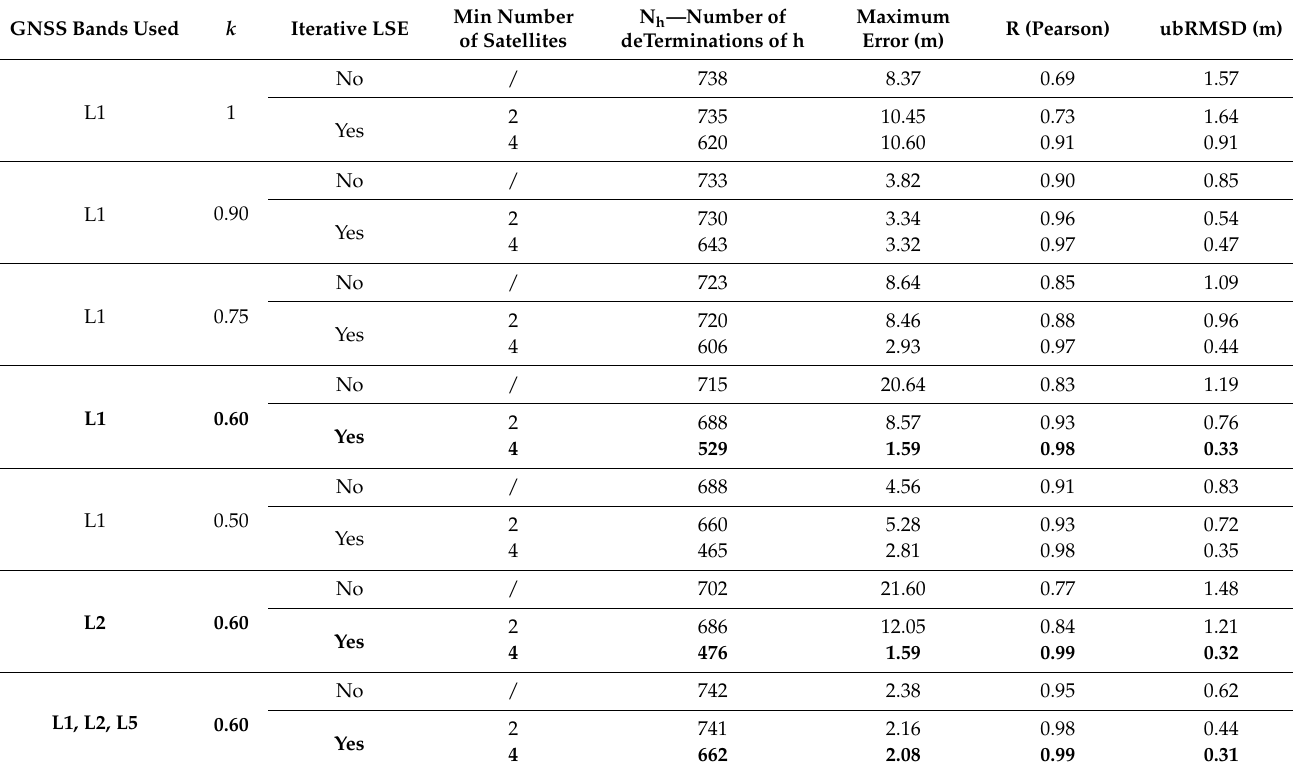
Table 1. Performances of the adapted dynamic SNR inversion of h depending on the filtering level k , the minimal number of satellites, and the bands of frequency used. The best statistical results for each GNSS band/ k parameter configuration were obtained with at least four satellites and new iterative LSE, while the worst results were obtained without the implementation of iterative LSE. Bold values highlight the best results for L1-only, L2-only and L1/L2/L5 height retrievals. GNSS Bands